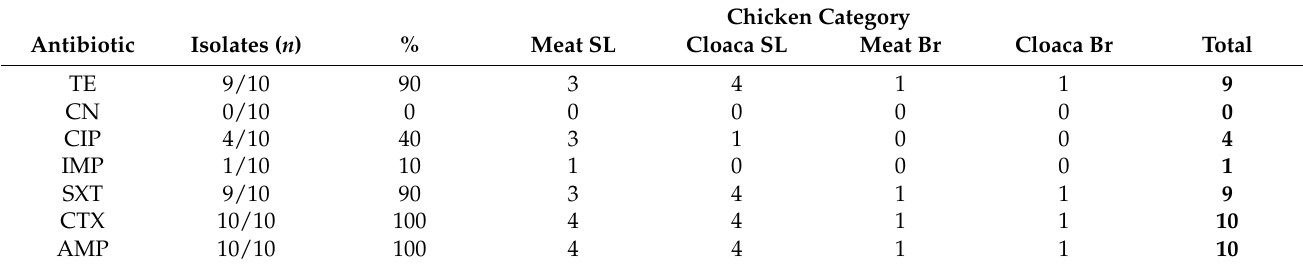
Table 4. Antimicrobial resistance of ESBL-producing E. coli isolates ( n = 10).